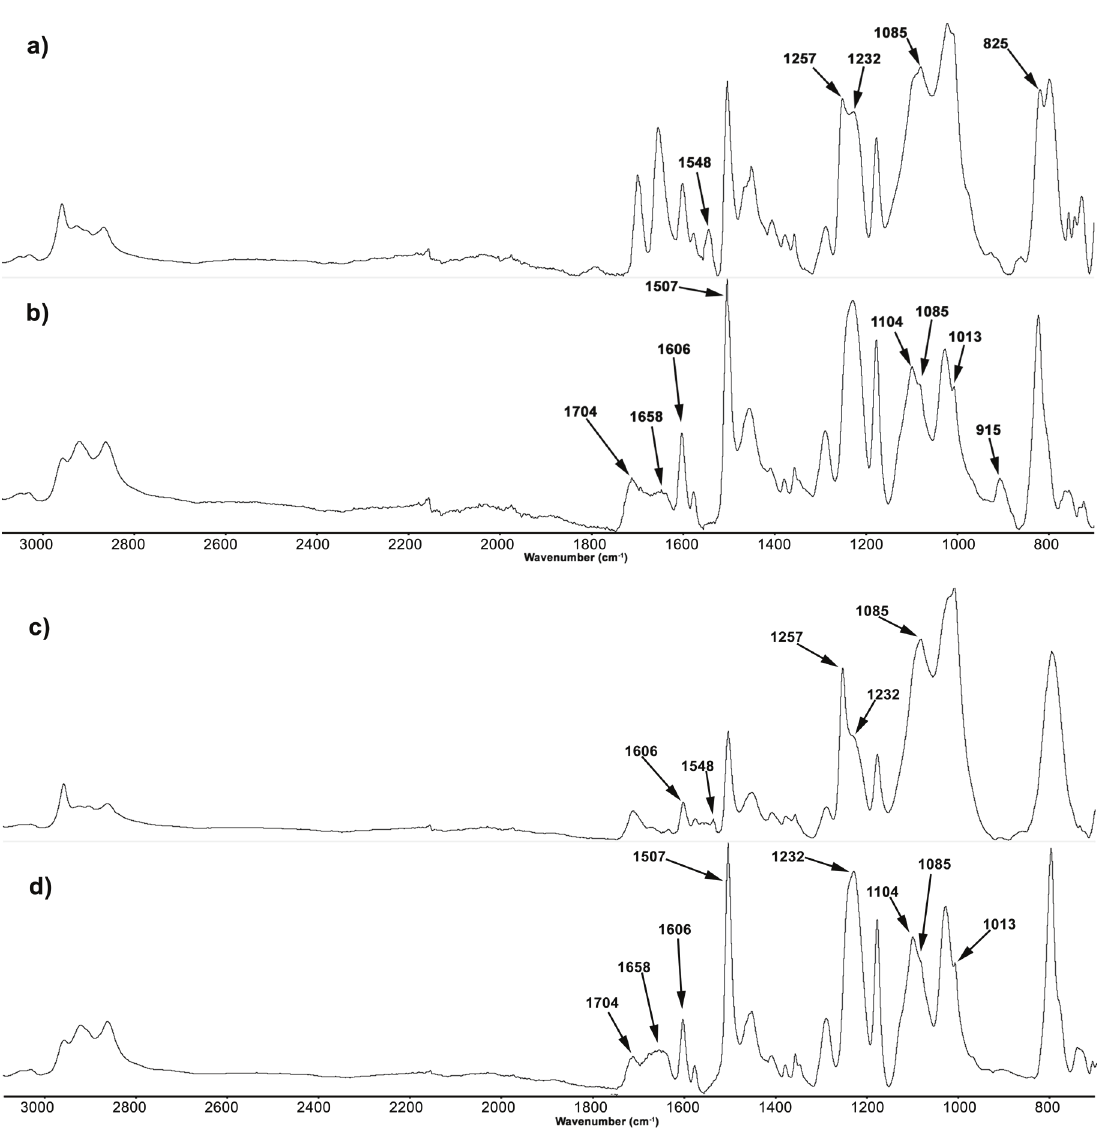
Figure 2: FT-IR spectra of (a) DER/MPTU/Pt, (b) DER/MPTU, (c) DER/DPTU/Pt and (d)